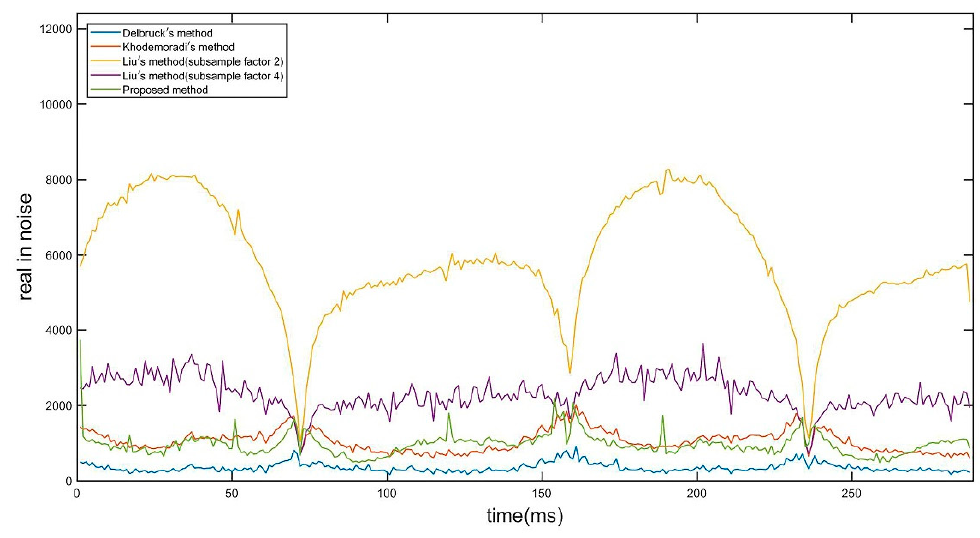
Figure 15. Real in noise (RIN) for each time period.